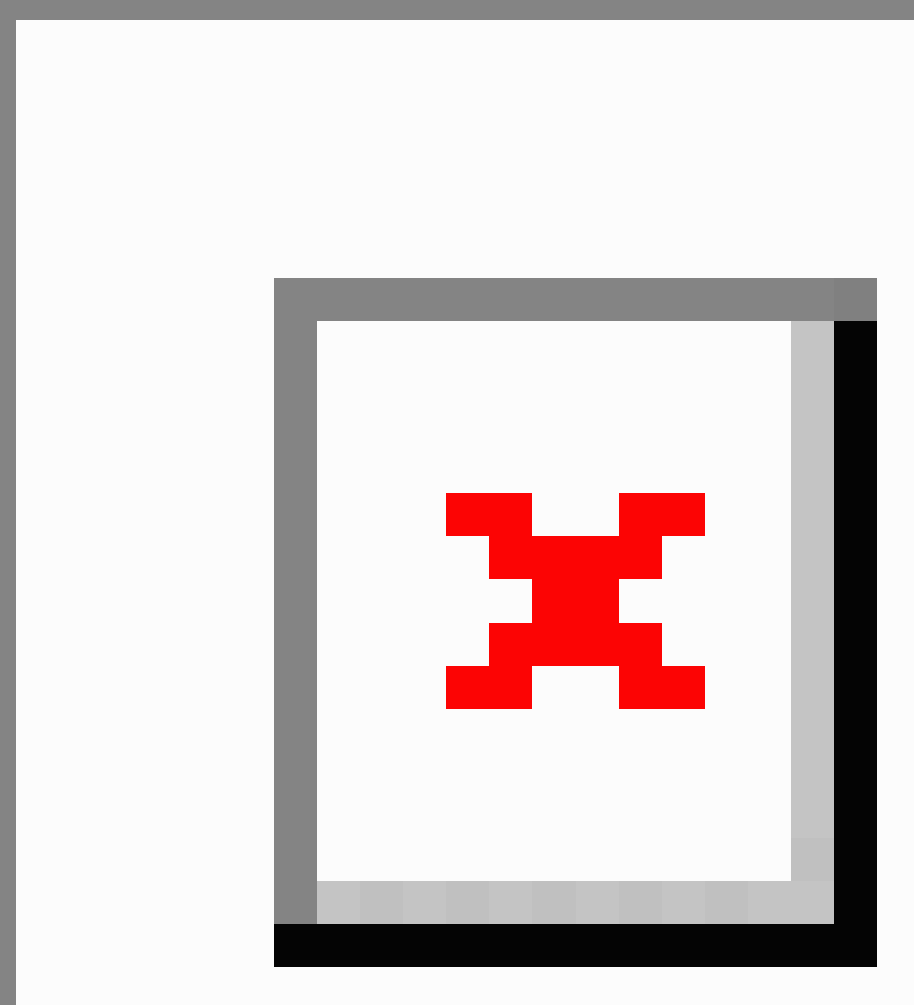
Figure 1. Study selection procedure according to the PRISMA